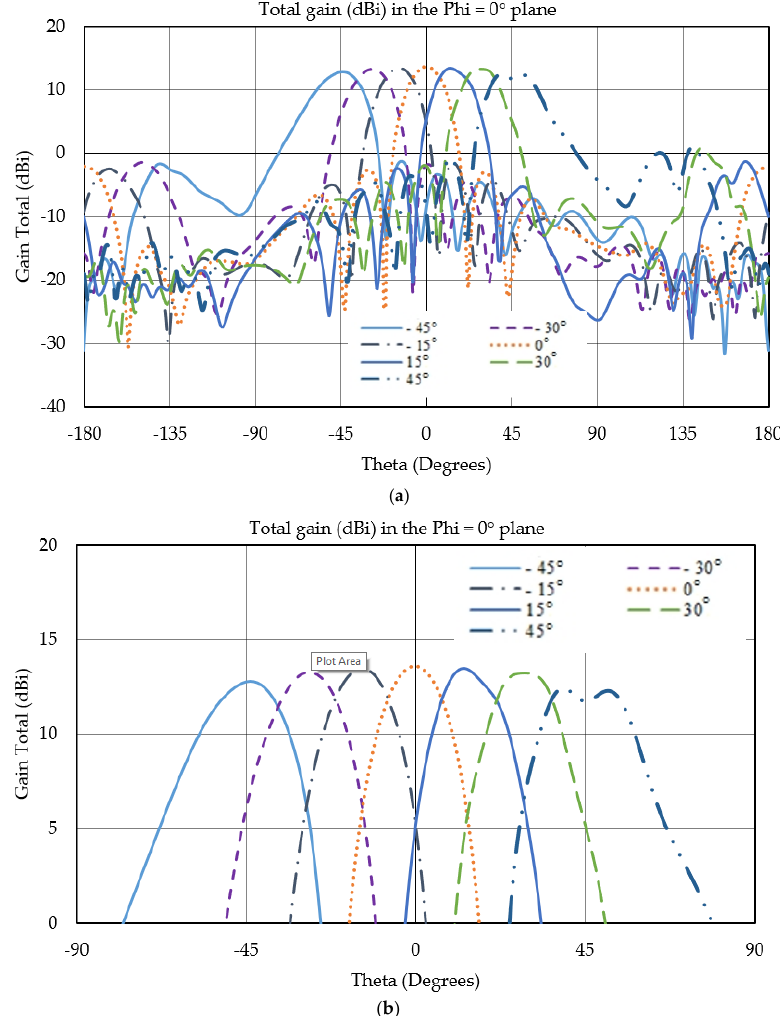
Figure 3. ( a ) Simulated array gains for various scanning angles in the elevation plane at 26.5 GHz. ( b ) Zoomed − in version of the gains for a smaller theta range.